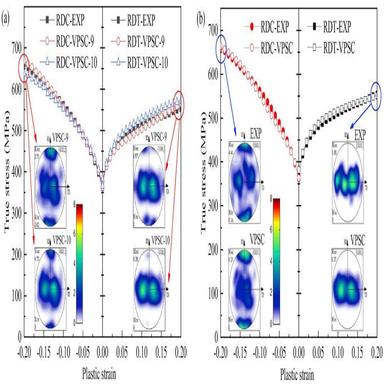
Comparison of the experimental and the predicted results: (a) the double objects optimization; (b) the multi-object optimization, indicating that the multi-object optimization method can capture the T-C asymmetry of both flow stress and texture evolution.